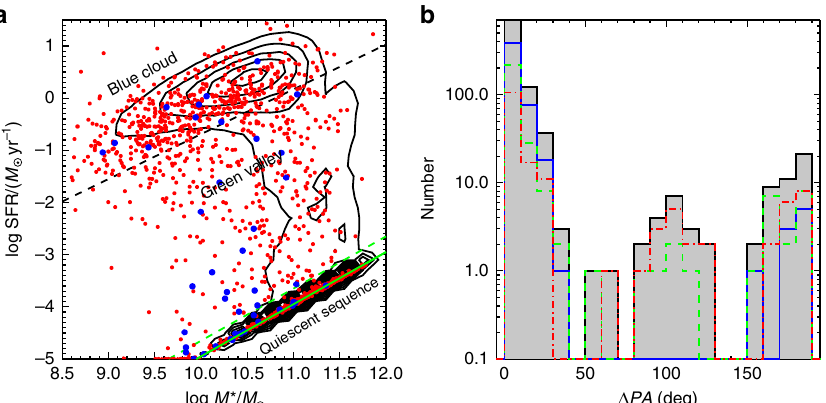
Figure 2 | SFRs versus stellar masses and D PA distribution. ( a ) SFRs versus stellar mass. Contours show the SDSS DR7 sample, while the red dots are MaNGA galaxies. The blue dots are the counter-rotators with D PA 4 150 (cid:2) . The two dashed lines separate the galaxies into blue star-formers, green valley and red quiescent galaxies. The black dashed line is adopted from Fig. 11 of ref. 18 as an approximation of the boundary (at the 1 s level in scatter) of the star-forming main sequence. The green solid line with log sSFR ( (cid:4) SFR/M * ) B (cid:2) 15 remarks red galaxies, in which the SFR can be neglected. The region between the black and green dashed lines is referred as the green valley. Although galaxies in the green valley have low SFR, they are clearly distinguished from red galaxies. We do not use the colour-magnitude diagram to separate blue from green and red galaxies since the colours are strongly effected by dust extinction. ( b ) D PA distribution for MaNGA galaxies with nebular emission. The grey histogram is for the whole sample, red for the red quiescent galaxies.